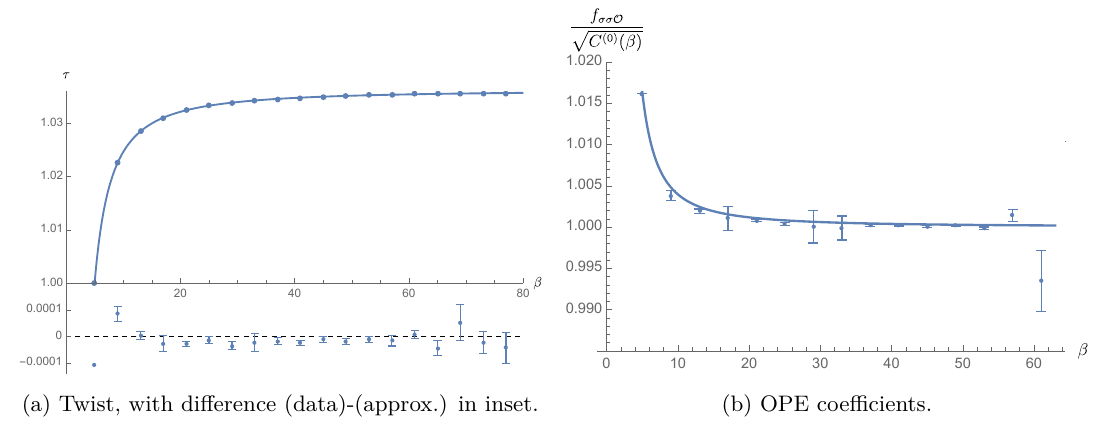
Figure 24 . Comparison of the large-spin approximation (B.4) for the [ σσ ] 0 family with the numerical data of [5], for the twist and OPE coefficients (divided by mean field theory). Only numerical errors are shown: discrepancies on the left-hand side of the plots should be attributed to shortcomings in the approximation not